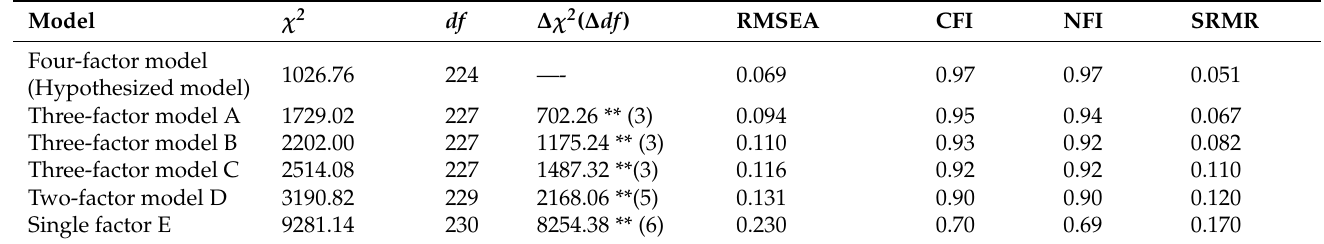
Table 1. Confirmatory factor analysis.